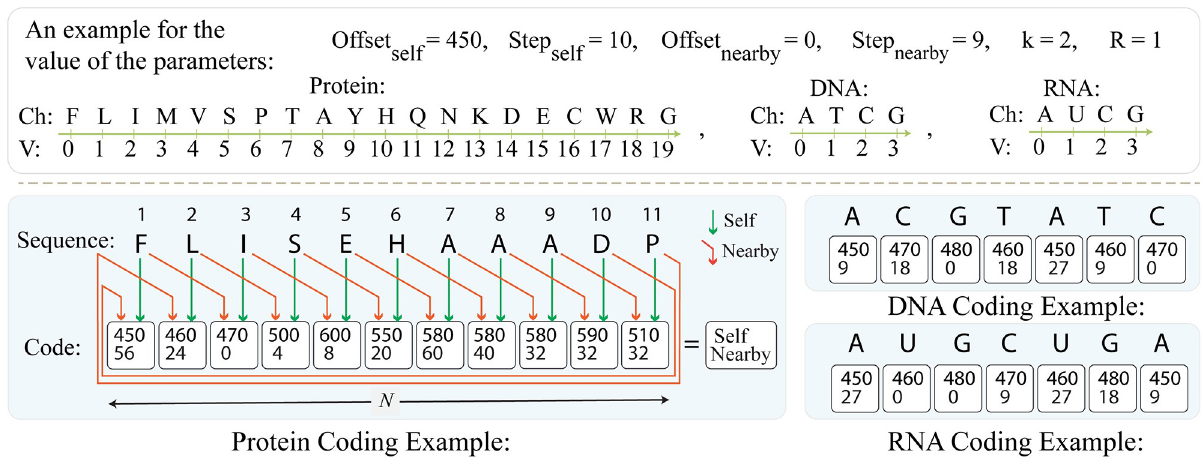
Fig 2. An example of the proposed coding scheme for DNA, RNA, and protein sequences. In this example, short DNA, RNA, and protein sequences are coded based on self-label and nearby-label coding schemes with preset values as follows: Offset self = 450, Step self = 10, Offset nearby = 0, Step nearby = 9, k = 2, and R = 1. The parameter Ch i stands for the character positioned in location i as the current character in the self-label coding, and the k th previous character in the nearby-label coding scheme. The parameter V represents a preset value between 0 to 19 for amino acids in the protein sequence and 0 to 3 for nucleotides in the DNA and the RNA sequences. Every character is coded with two values determined by the self-label and nearby-label coding schemes, as represented in its corresponding white block. For nearby-label coding of those characters positioned at the beginning of the sequence, the nearby-label coding wraps around the sequence and considers the desired nearby character at the end of the